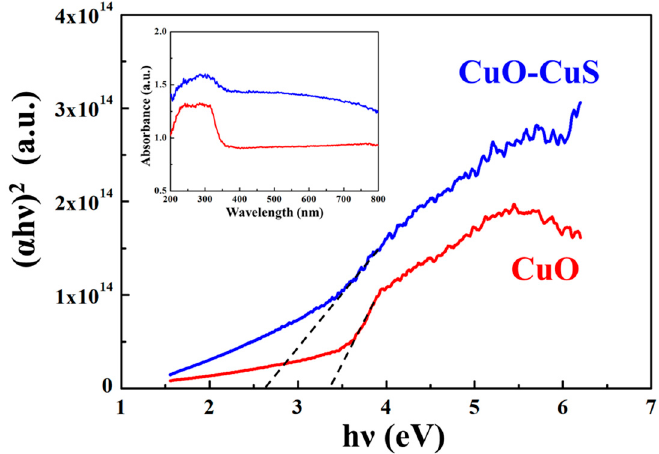
Figure 4. Tauc plot of CuO-CuS and CuO nanowires. The inset is UV-Vis diffuse reflectance spectra (DRS).